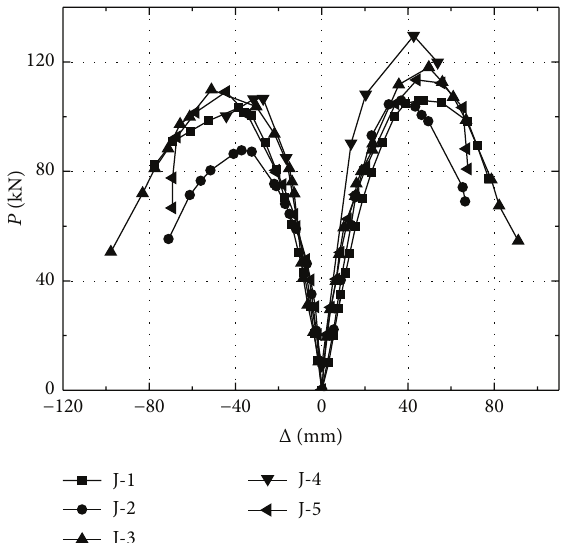
Figure 20: Force versus displacement skeleton curve.